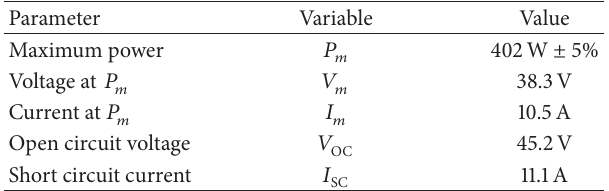
Table 1: Typical electrical characteristic of the HCPV/T